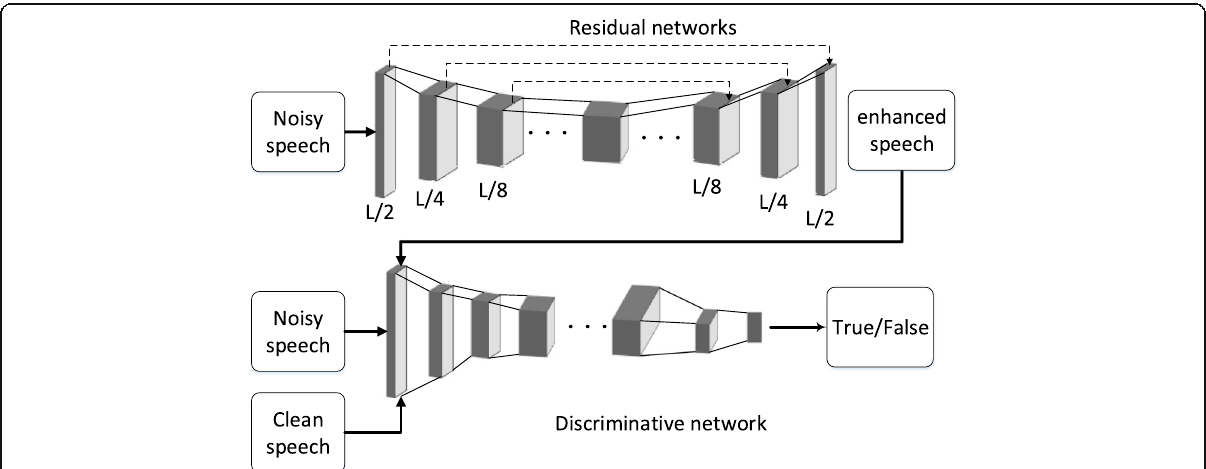
Fig. 3 The structure of speech enhancement WCGAN. The resulting dimensions per layer is 16,384 × 1, 8192 × 16, 4096 × 32, 2048 × 32, 1024 × 64, 512 × 64, 256 × 128, 128 × 128, 64 × 256, 32 × 256, 16 × 512, and 8 × 1024. The decoder stage of G is a mirroring of the encoder with the same filter widths and the same amount of filters per layer. The residual network makes training stable and noisy speech vector makes the number of feature maps in every layer to be